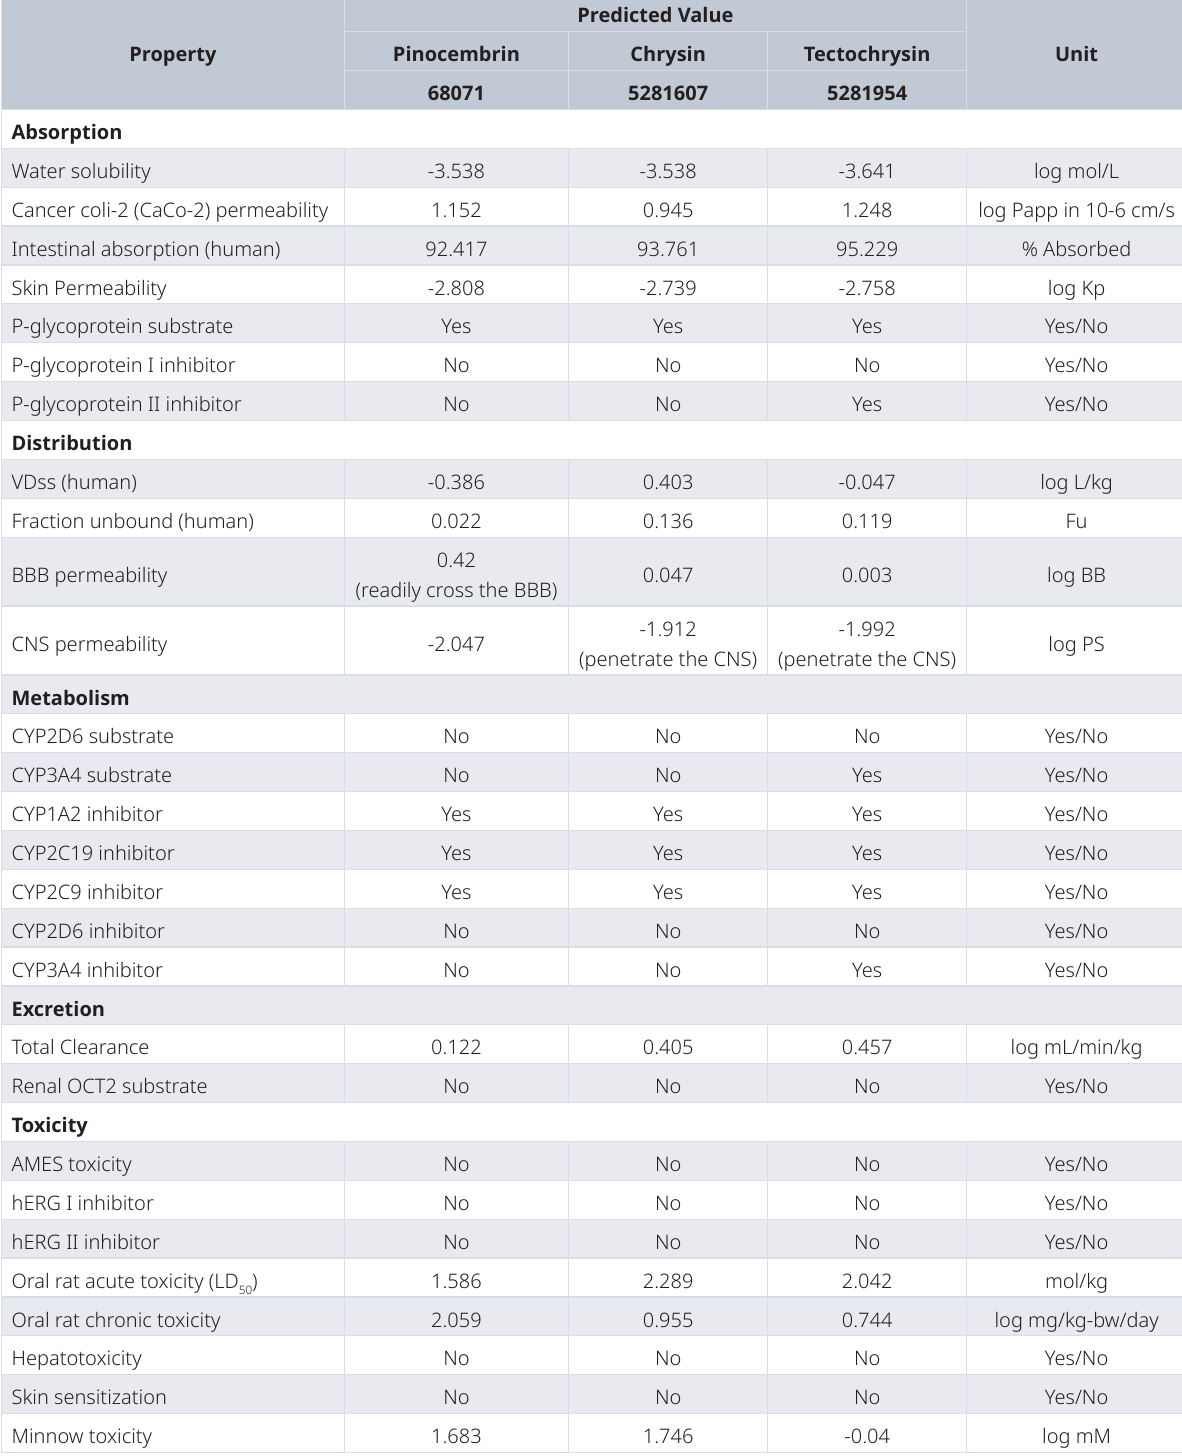
Table 5. Pharmacokinetics and toxicity prediction of the